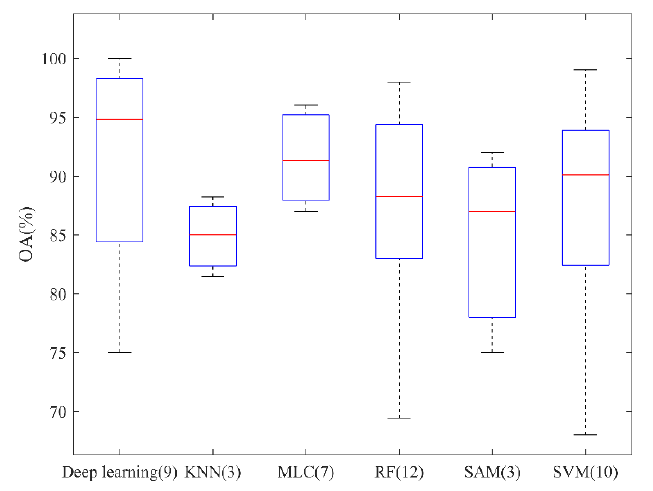
Figure 19. The overall accuracy of different classifiers.